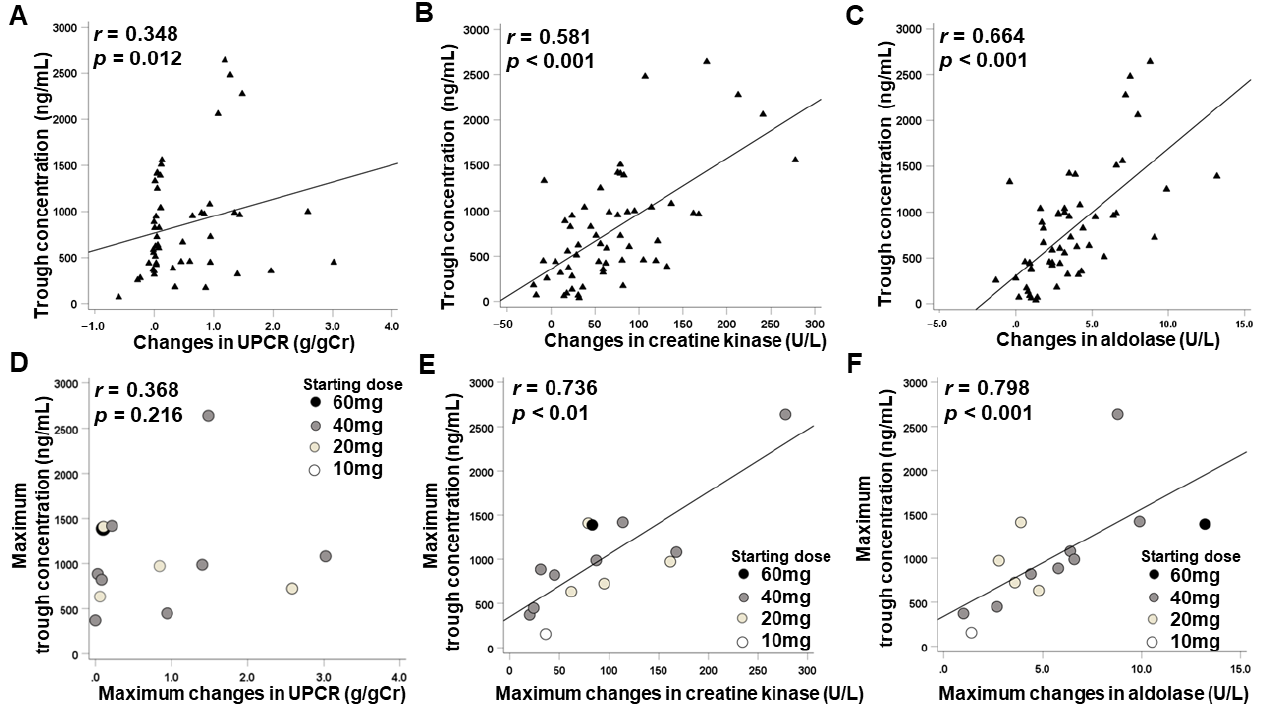
Figure 3. Correlations between all values of changes from baseline in urine protein-to-creatinine ratio (UPCR), serum creatine kinase, and serum aldolase and C trough of cabozantinib at any point ( A – C ), and correlations between maximum changes in UPCR, serum creatine kinase, and serum aldolase and maximum trough concentration of cabozantinib ( D – F